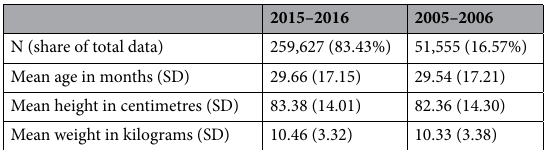
Table 5. Summary of the data